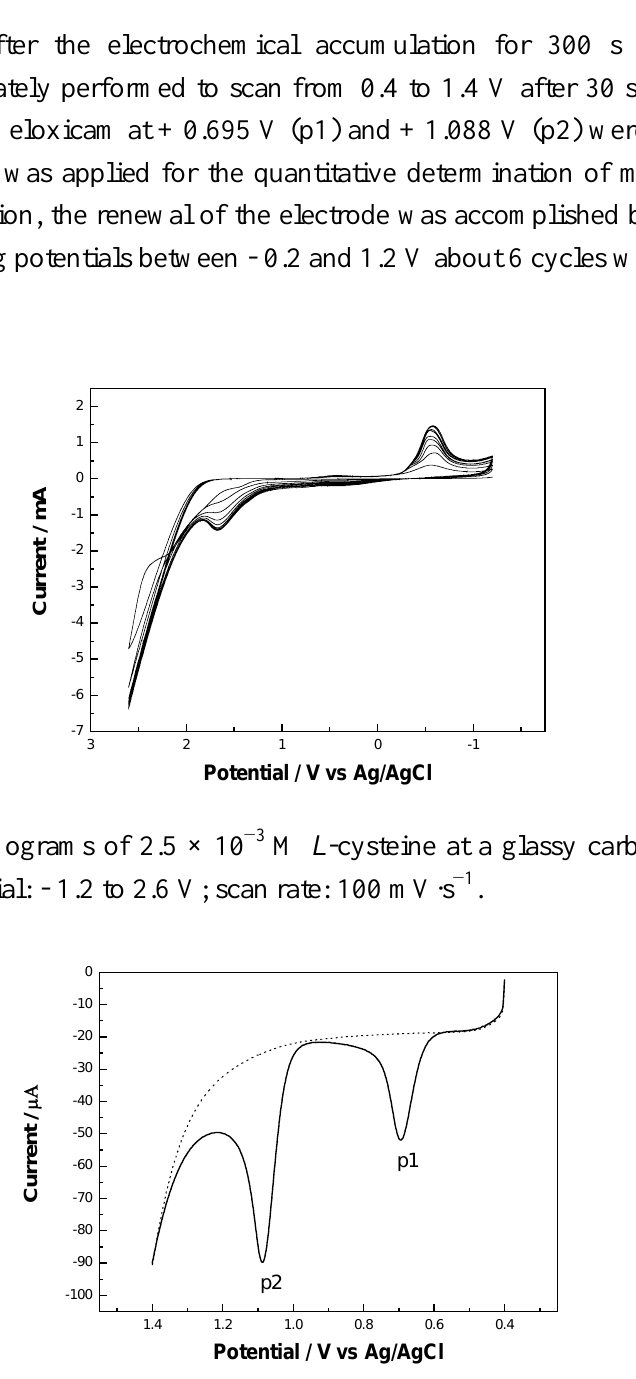
Figure 2. Adsorptive voltammograms of 3.5 × 10 -6 M meloxicam (solid line) and blank (dot line) at the modified electrode in the B-R buffer solution (0.04 M, pH 1.86). Accumulation potential under stirring: - 0.2 V; accumulation time: 300 s; quiet time: 30 s; scan rate: 100 mV·s -1